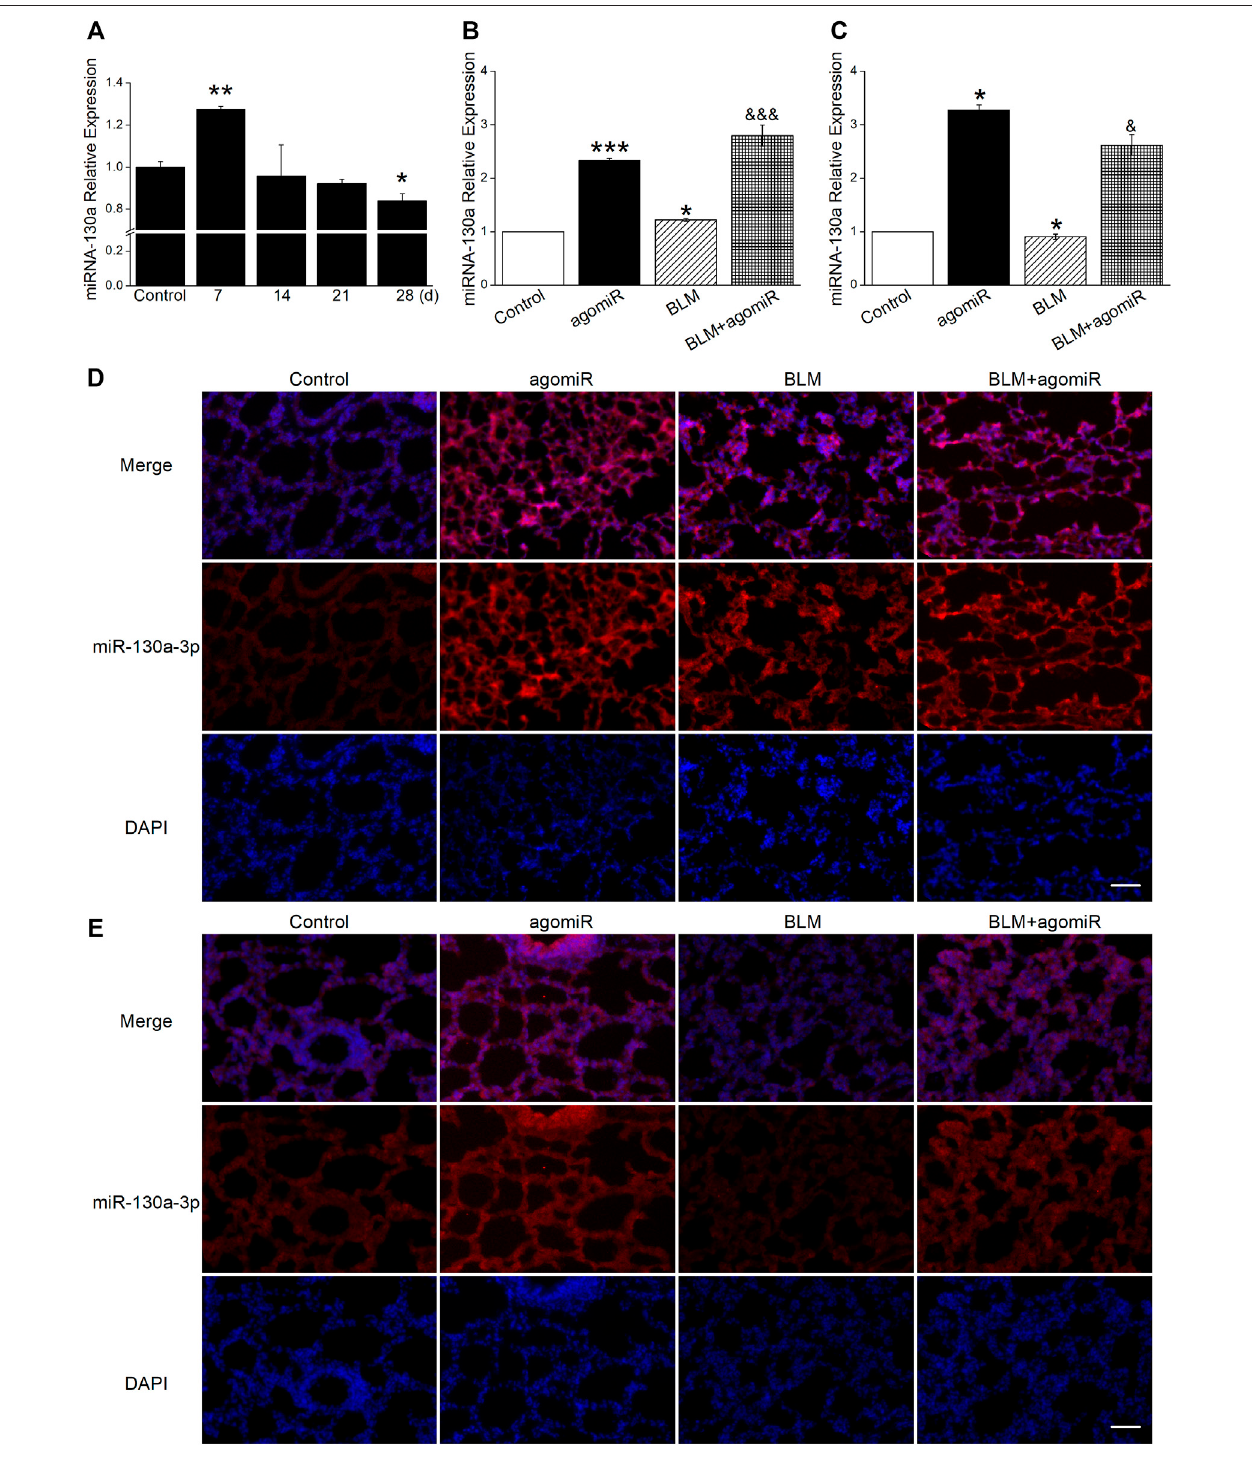
FIGURE 3 | MiR-130a-3p expression correlates with in fl ammatory and fi brotic phases. (A) qRT-PCR quantitation of miR-130a-3p expression at different times after BLM treatment. * p < 0.05, ** p < 0.01, versus the control group, by the Mann – Whitney U test, n = 3 – 4. (B) qRT-PCR quantitation of miR-130a-3p expression in the in fl ammatory phase after BLM and/or miR-130a-3p agomiRtreatment. * p < 0.05, *** p < 0.001, versusthe control group; &&& p < 0.001, versus theBLM group, one-way ANOVA followed by Bonferroni ’ s test, n = 3 – 4. (C) qRT-PCR quantitation of miR-130a-3p expression in the fi brotic phase after BLM and/or miR-130a-3p agomiR treatment.* p < 0.05,versusthecontrolgroup; & p < 0.05,versustheBLMgroup,bytheMann – Whitney U test, n =4 – 5.FISHanalysisofmiR-130a-3pinlungtissuesfrom the (D) in fl ammatory phase and (E) fi brotic phase. miR-130a-3p-positive (red) and DAPI (blue). Scale bar = 50 µm.